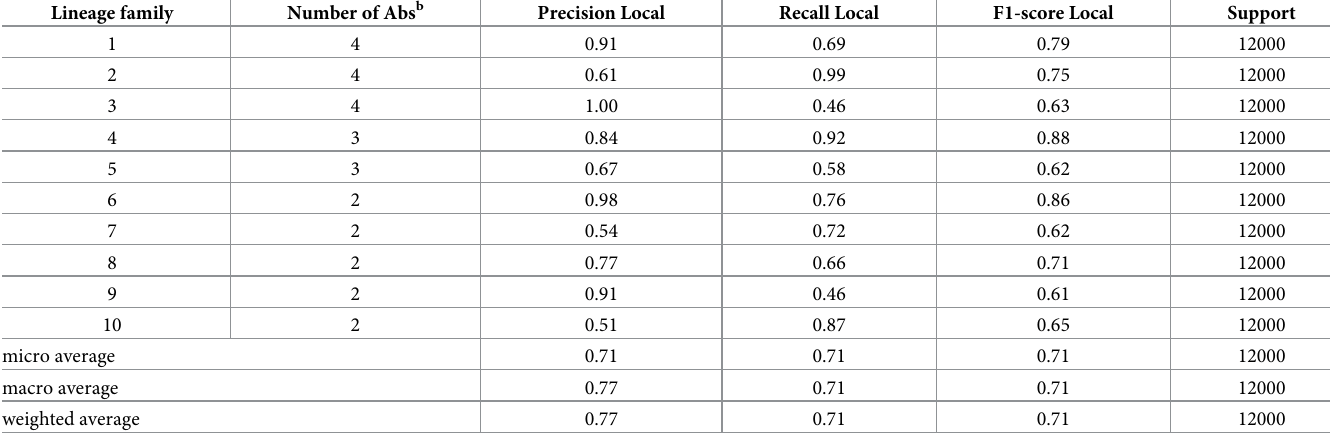
Table 4. Detection of a specific lineage family. Summary statistics a of 80 DNN models used for classification of 28 antibodies belonging to ten family lineages using fin- gerprints colored according to the charge coloring code. Lineage family